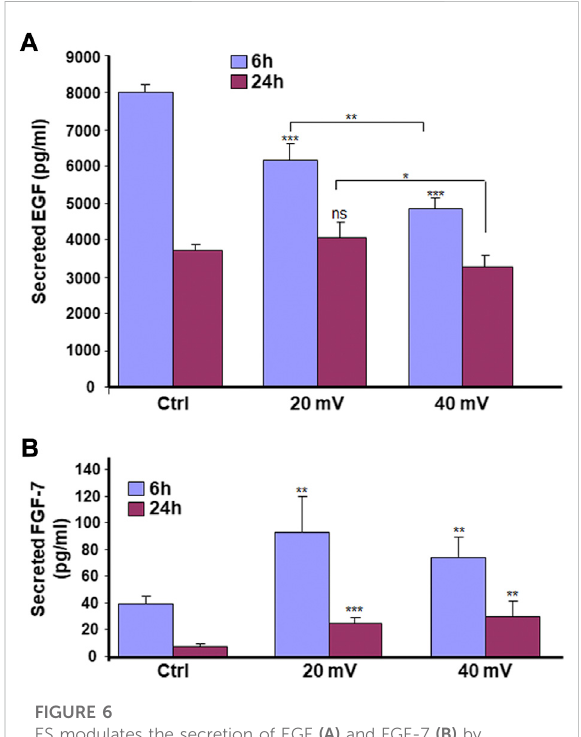
FIGURE 7 ES modulates the secretion of MMP2 (A) and MMP9 (B) by diabetic skin cells. DHSE were exposed to 20 or 40 mV/mm of ES for6and24 h.Immediatelyaftereachexposureperiod,theculture mediumwasusedtomeasurelelevelsofMMP2andMMP9as reported in the M&M. Results are expressed as means ± SD from triplicate assays of three different experiments. (ns),